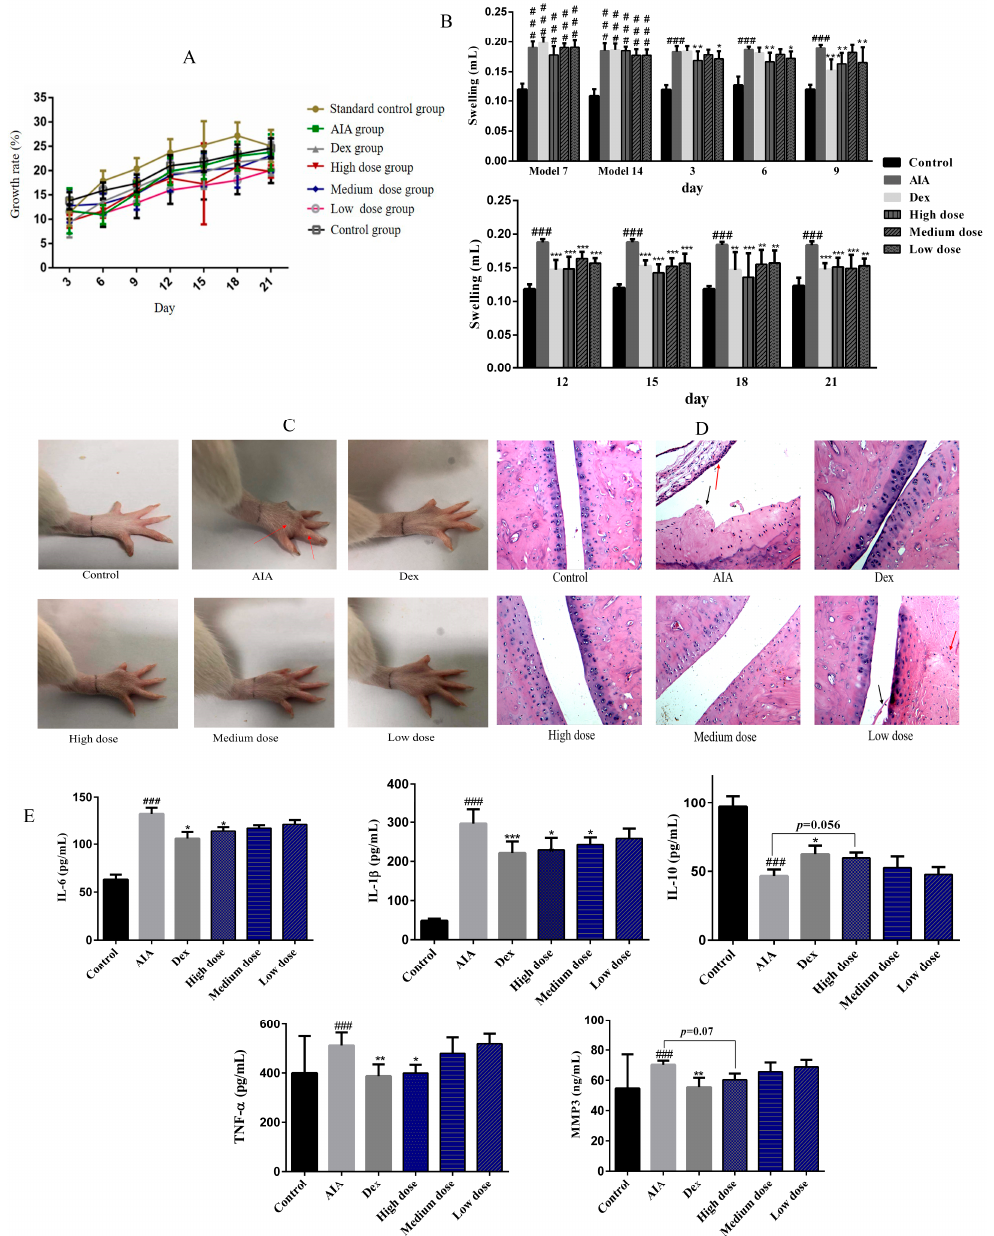
Figure 3. Effect of purpurin on weight, foot swelling, and joint damage in rats. ( A ) The changes in the weight of rats during administration. ( B ) The foot swelling of rats. ( C ) The appearance of foot in different groups after administration of the respective drugs for 21 days, paw swelling of AIA rat was marked by a red arrow. ( D ) H&E staining (magnification: 100-fold) of the joints after administration of the respective drugs for 21 days, red arrow: inflammatory cell infiltration, black arrow: cartilage destruction. ( E ) The effect of purpurin on IL-6, IL-1 β , IL-10, TNF- α and MMP3 of AIA rats. Dex: dexamethasone; AIA: adjuvant-induced arthritis. Data are represented as mean ± SD. ### p < 0.001 vs. control. *** p < 0.001, ** p < 0.01, * p < 0.05 vs. model, n =